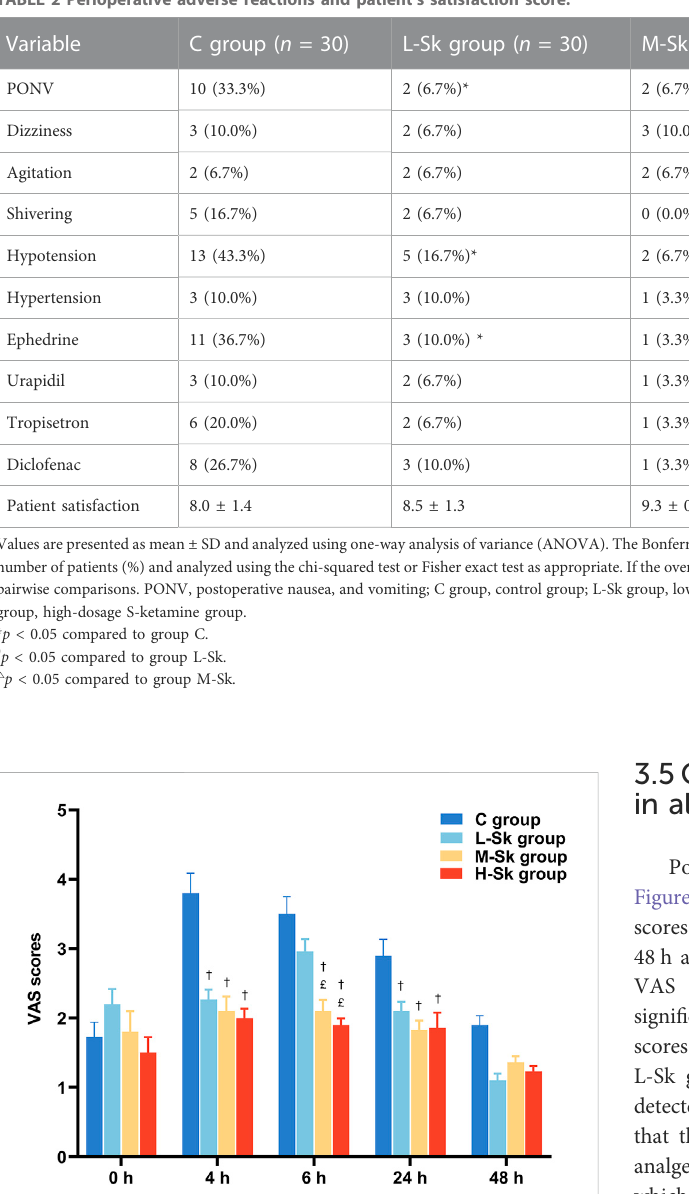
TABLE 2 Perioperative adverse reactions and patient ’ s satisfaction score.